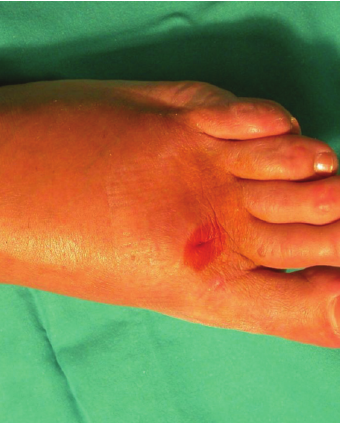
Figure 1: Nocardiosis: soft tissue inflammation localized in the left metatarsus-phalangeal articulation, associated with a cutaneous fistula, occurred during the 50th post-operative